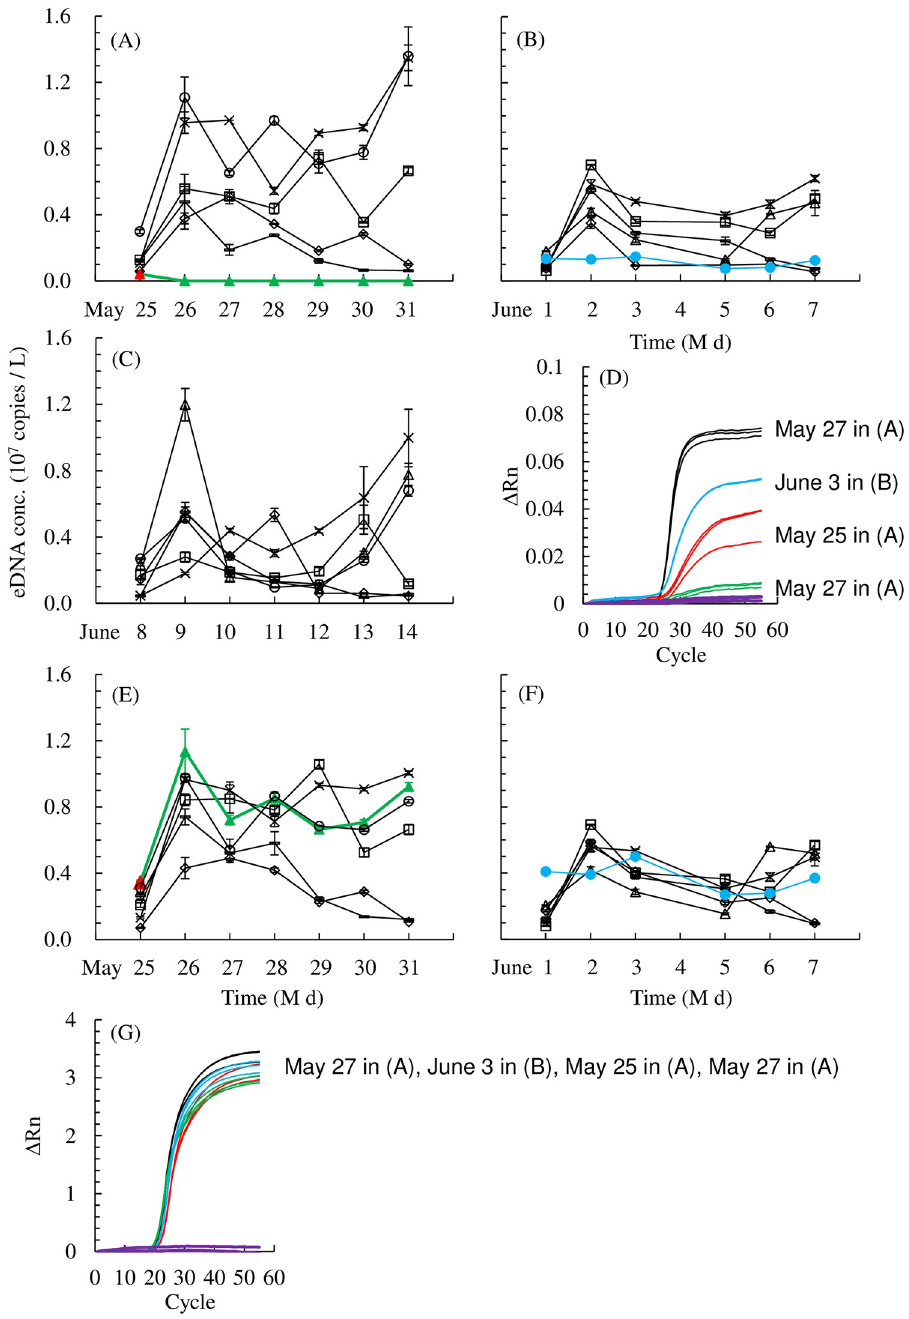
Fig 2. (A), (B), (C) Inter-individual variation in eDNA concentration (eDNA conc.) in 18 individual Japanese eels and (E), (F) in 12 individual Japanese eels, and (D), (G) amplification curves. (A), (B), (C), (D) the TaqMan method using species-specific primers and probe sets. (E), (F), (G) an intercalator method with SYBR Green. Black: Controls; red and green: Variant-1 (first day; second or later day of the first cycle); blue: Variant-2 (second cycle); purple: Negative controls; square: A-1; diamond: B-1; triangle: C-1; cross: A-2; bar: B-2; circle: C-2. Error bars represent standard deviations (SD) of PCR replication.